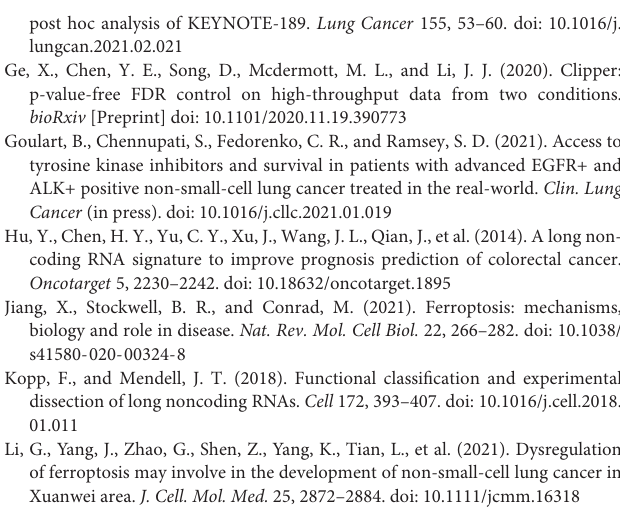
validation sets. Supplementary Table 1 | List of the 259 ferroptosis-related